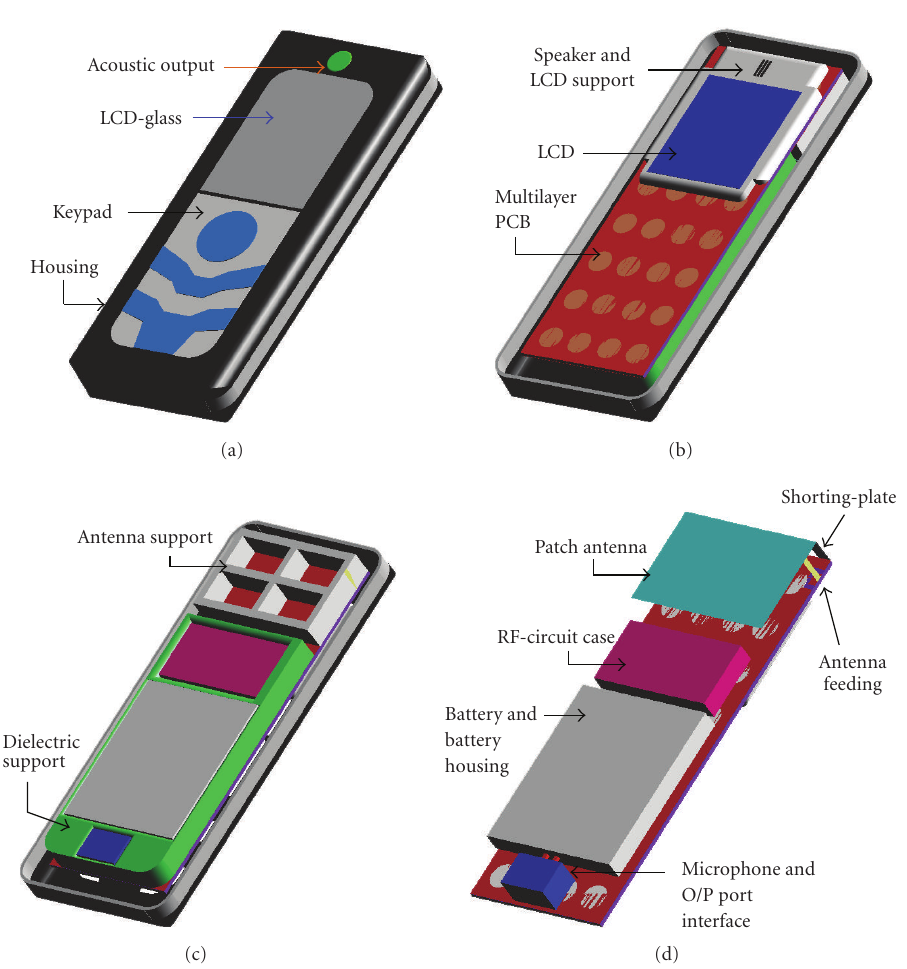
Figure 2: The SEMCAD X representation of the handset with internal antenna (model-B1) showing di ff erent components and parts in di ff erent